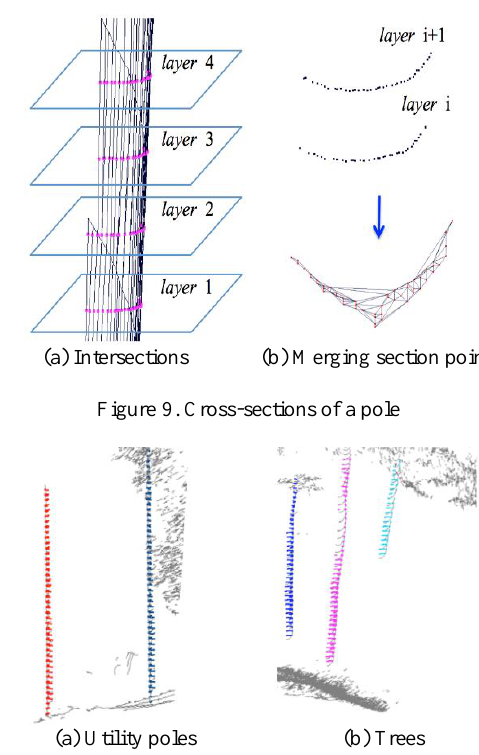
Figure 8. Addition of edges between scan-lines